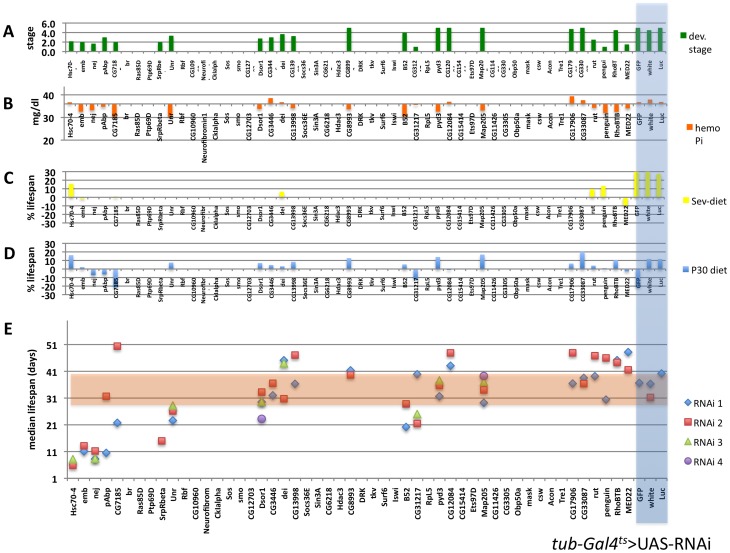

In vivo secondary screen using the tub-Gal4
ts as driver identifies genetic modifiers of Drosophila larval development, and adult hemolymph phosphate and lifespan. A:Developmental stage on standard medium, B: hemolymph phosphate concentration of young adult females cultured at 29°C for five days, and % change of life span on standard medium supplemented with 1% sevelamer (C), or 30 mM sodium phosphate (D) when compared to standard medium alone (E) (see also Table S1).